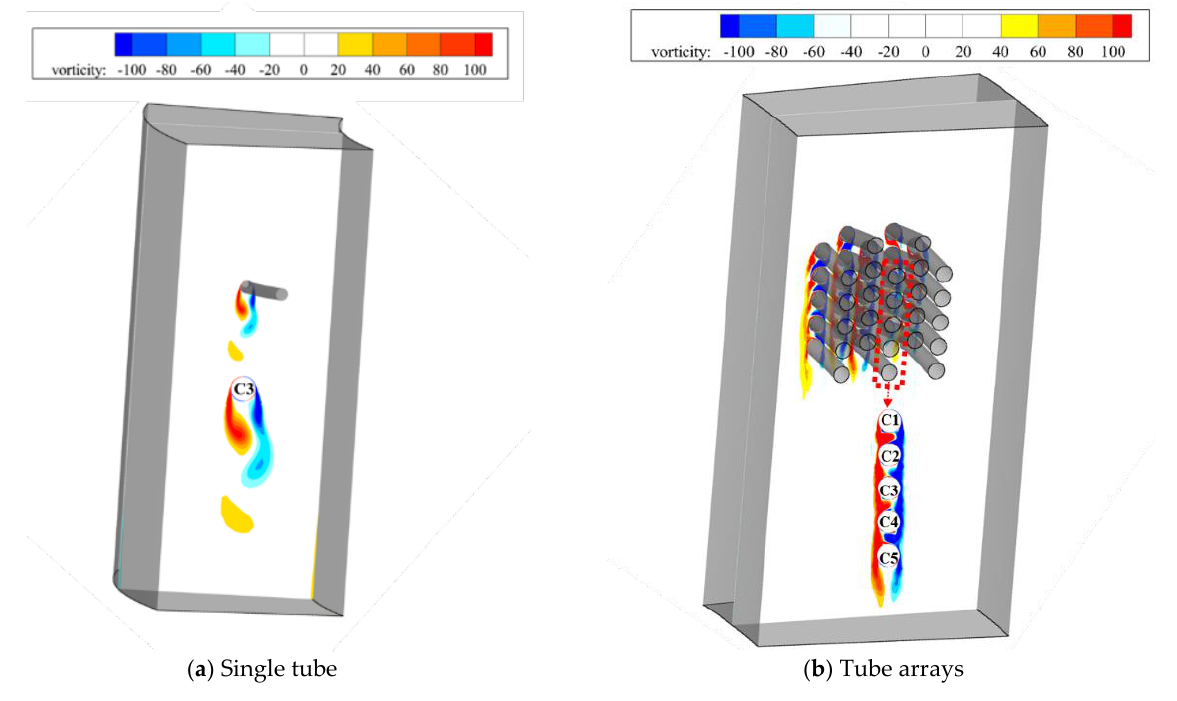
Figure 9. Plane vortices of Z = 0 near C3 in single tube and tube arrays. Table 3. Radial root mean square displacement of the C3 vibration response.